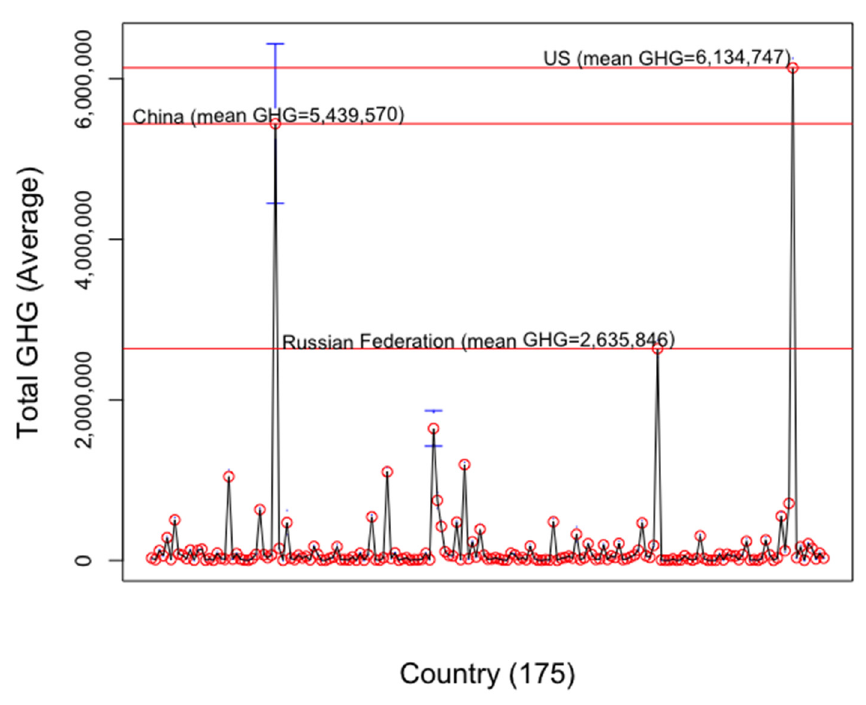
Figure 1. Historical trend of mean GHG emissions in 175 countries (1970–2018).